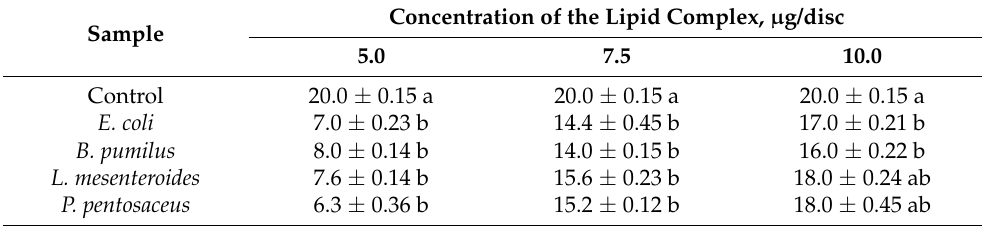
Table 5. Antimicrobial activity (zone of inhibition, mm) of the A. platensis lipid